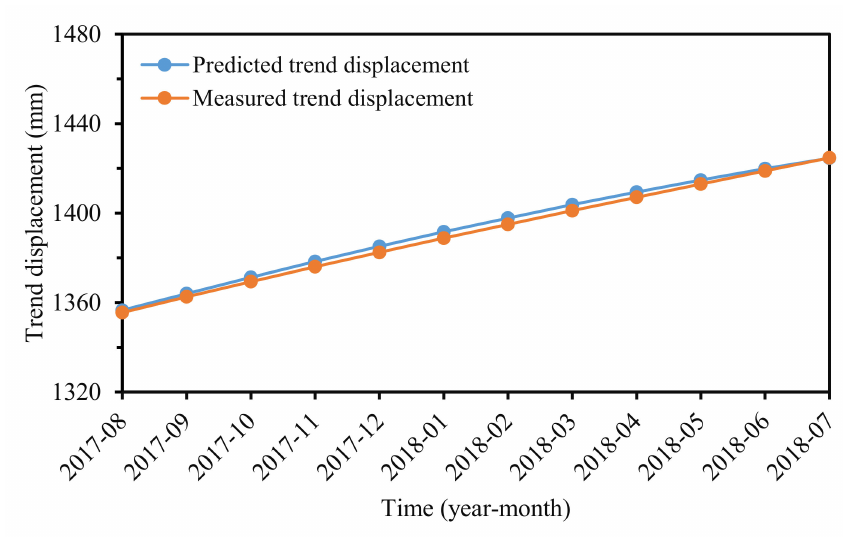
Figure 12. Predicted and measured trend